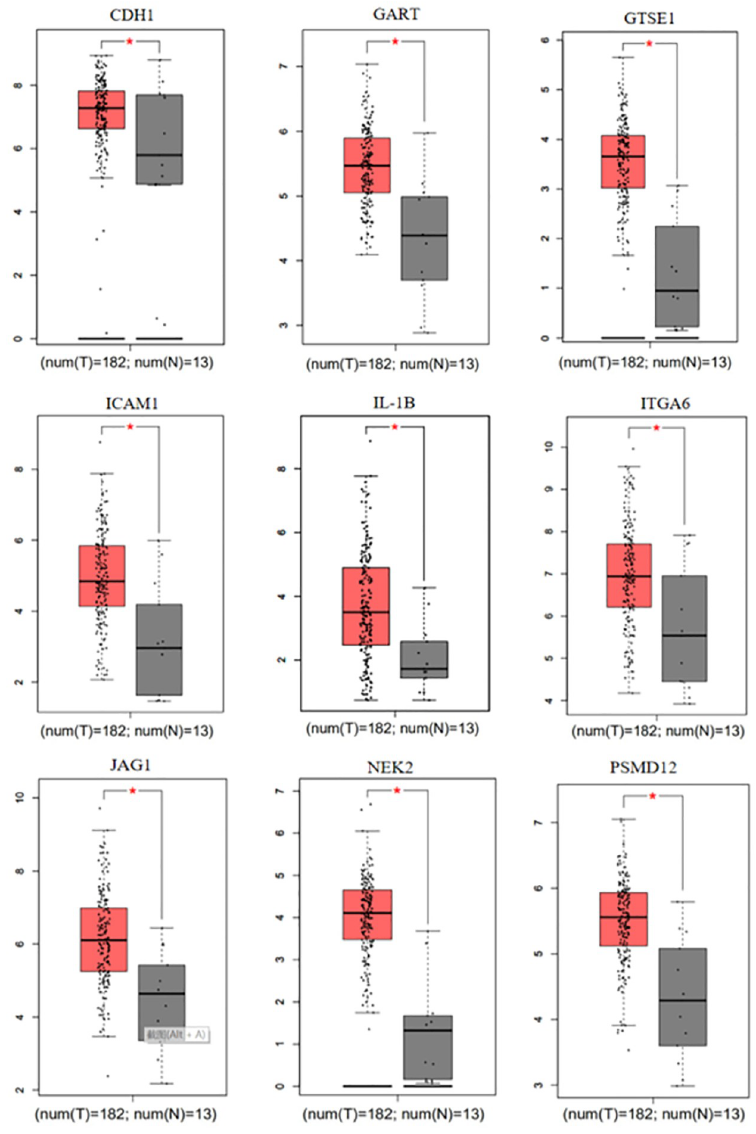
Fig 6. Expression of significant DEGs in the TCGA dataset. Expression of significant DEGs between EAC and normal tissue in the TCGA dataset. Red column represents the expression of EAC, gray column represents the expression of normal tissue. � respresents the P value <